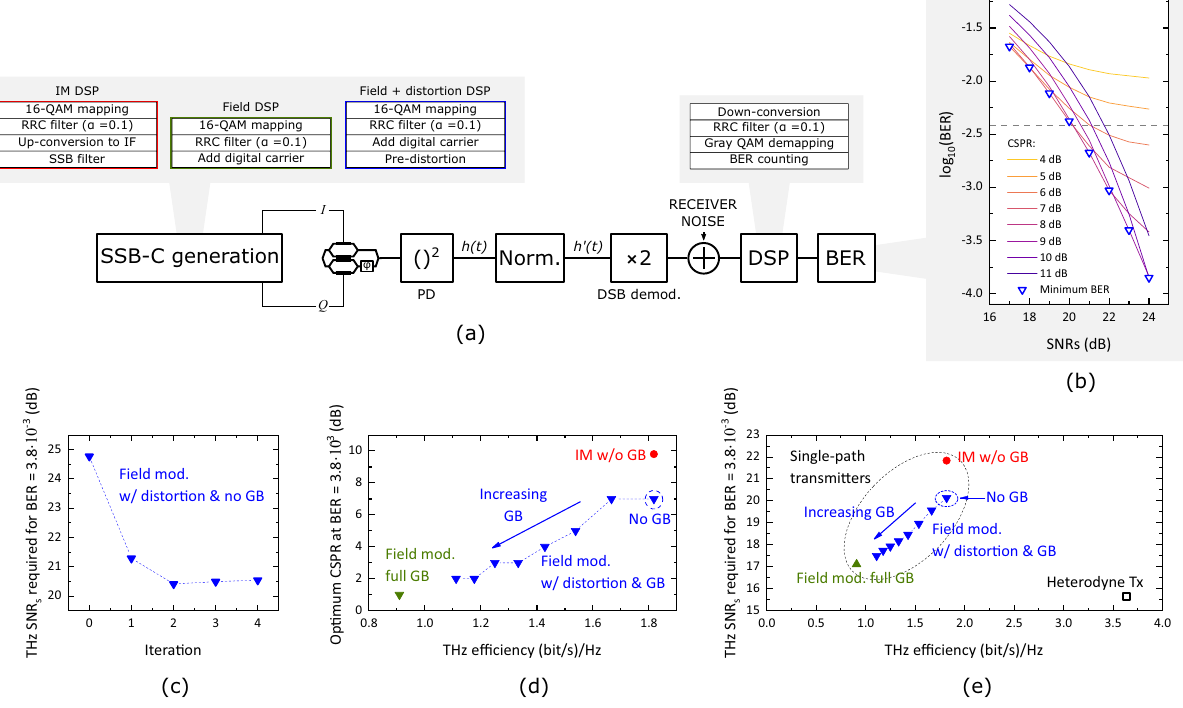
Figure 4. ( a ) Structure of the simulations ( h ( t ) and h ′ ( t ) are mathematically defined in equations S5 and S6 of the supplementary information) and digital signal processing (DSP) used in each SSB-C scheme; ( b ) BER curve obtained for field modulation plus pre-distortion SSBI compensation with no GB; ( c ) sensitivity at a BER of 3.8 × 10 -3 versus number of iterations in the pre-distortion technique; ( d ) optimum CSPR versus THz efficiency for each of the SSB-C signals simulated; and ( e ) sensitivity versus THz efficiency of each scheme (including the heterodyne system—black square) at the HD-FEC limit of 3.8 × 10 -3